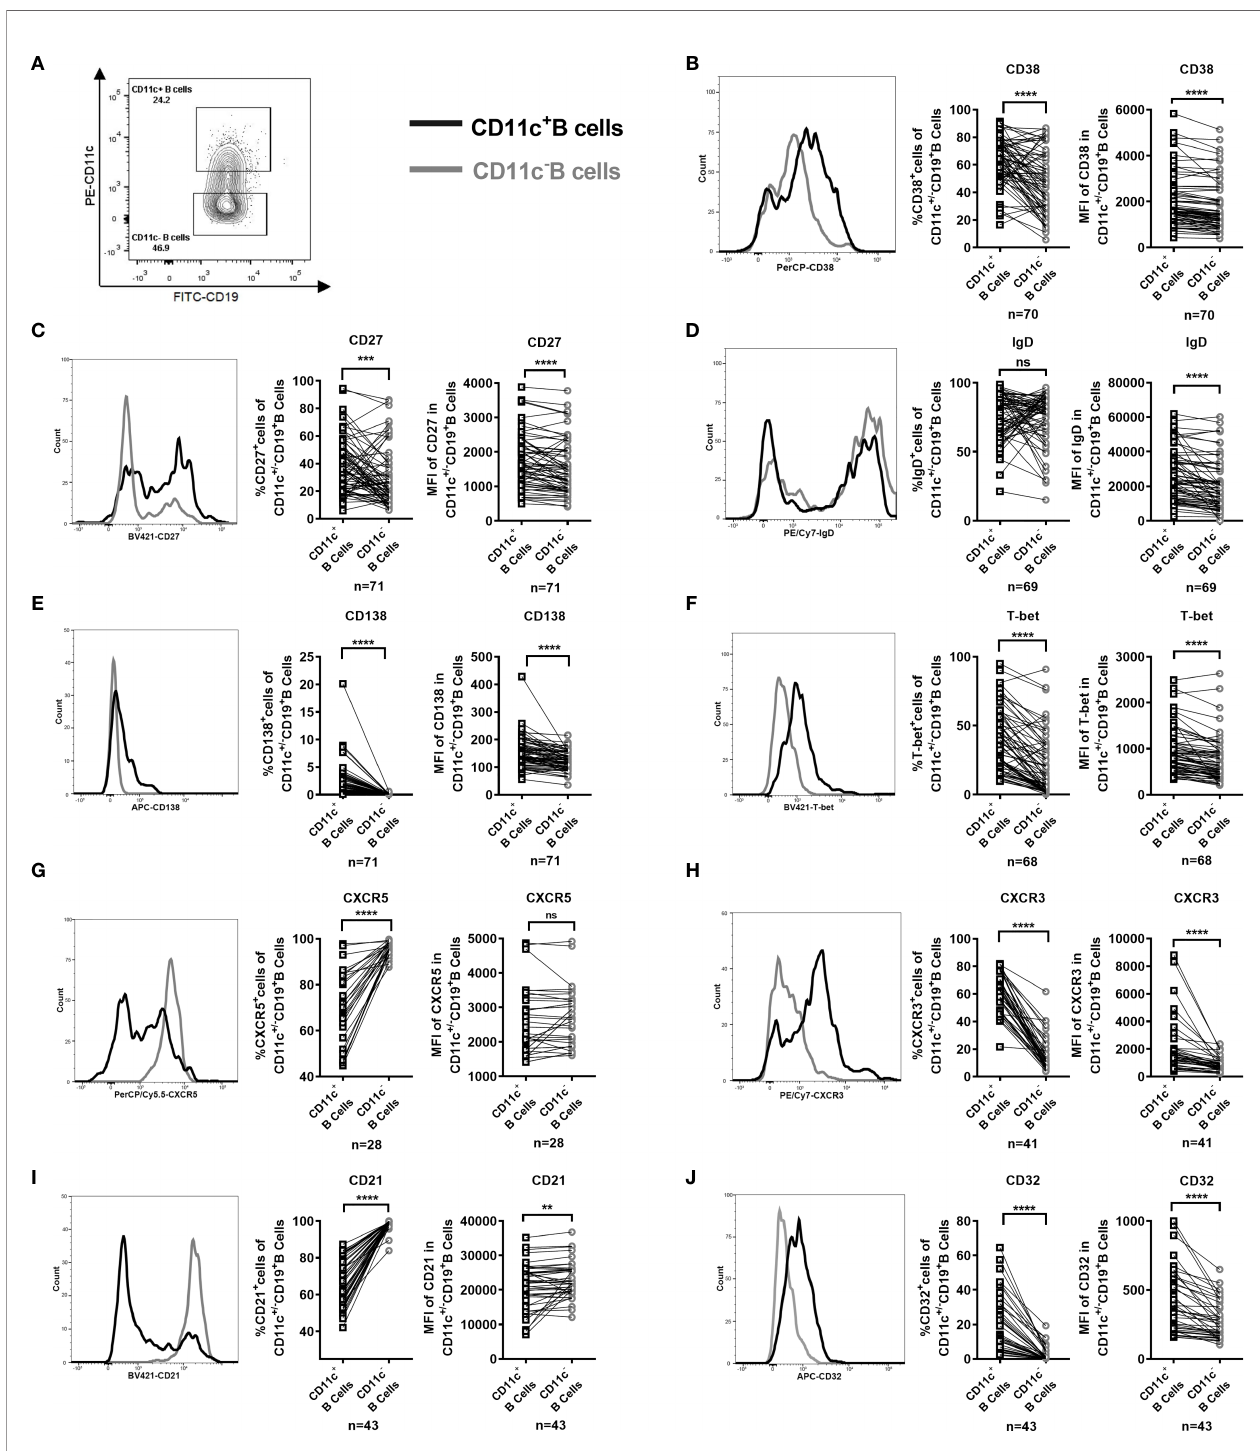
FIGURE 4 | Phenotype of paired CD11c + B cells and CD11c - B cells in the peripheral blood (PB) of GD patients. (A) Representative fl ow cytometric plots of CD11c + B cells and CD11c - B cells in the PB of GD patients. (B – J) Comparative overlapped histograms of the PB example in CD11c + and CD11c - B cells for compared markers (left). Comparison between the frequency of subsets of CD11c + B cells and that of paired CD11c - B cells in each PB sample (middle). Comparison between the mean fl uorescence intensities (MFIs) of the representative phenotype of CD11c + B cells and that of paired CD11c - B cells in each PB sample (right). The comparison metrics included conventional antigens (CD38, CD27, IgD, and CD138), an unconventional antigen (T-bet), chemokine receptors (CXCR3 and CXCR5), and autoimmune-related antigens (CD32 and CD21). Data were compared between two groups with a paired Student ’ s t test. P < 0.05 was considered statistically signi fi cant. ns, not signi fi cant; ** P < 0.01; *** P < 0.001; **** P <